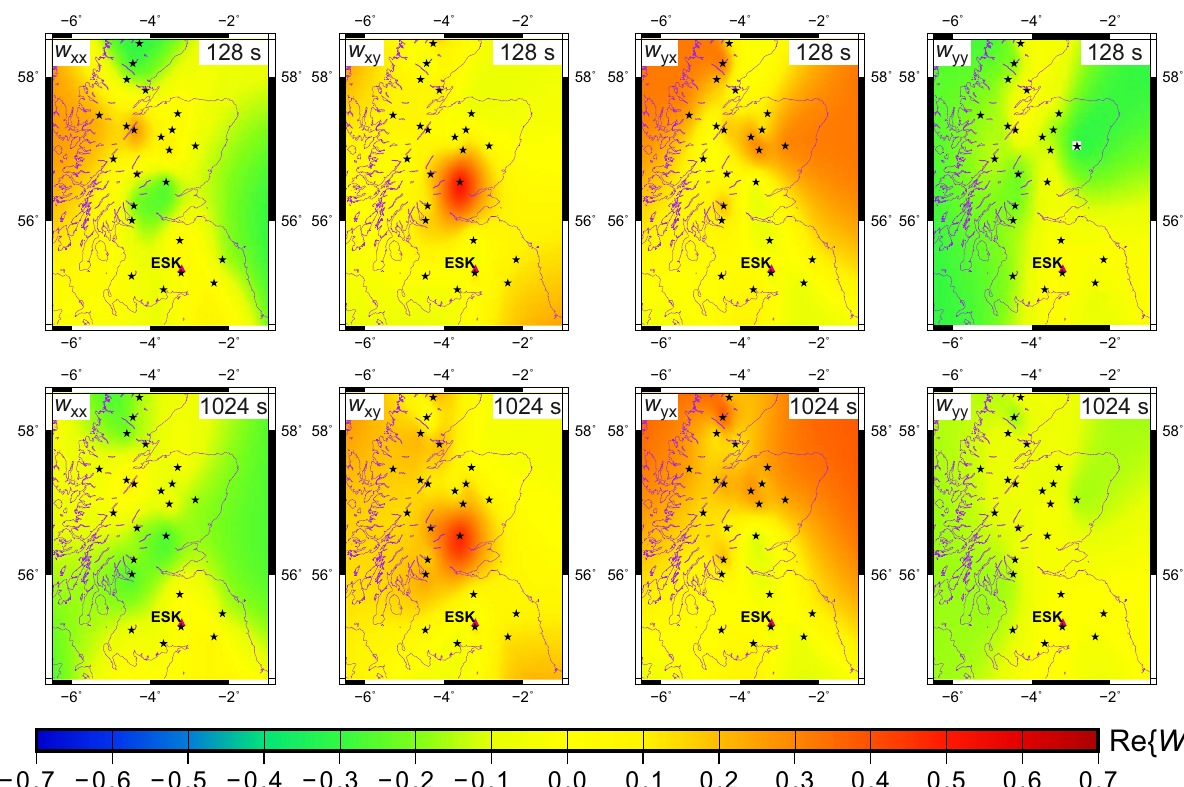
Fig. 2. Horizontal real components of the perturbation tensor, W ij , at periods of 128 s and 1024 s interpolated using bicubic splines (Smith & Wessel, 1990). Stars indicate MT measurement